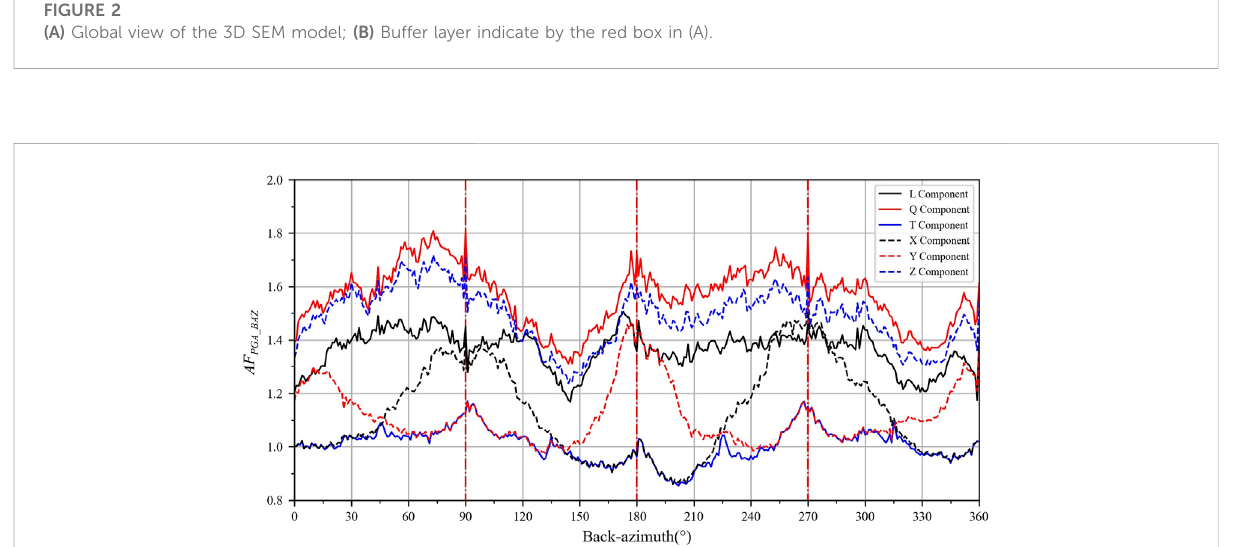
FIGURE 3 The relationship of AF PGA BAZ with back-azimuth, taking 1 ° as the interval. The solid black, red, and blue lines correspond to the L, Q, and T components, respectively; the dashed black, red, and blue lines correspond to the X, Y, and Z components, respectively. The red vertical dashdot lines are at 0 ° (360 ° ), 90 ° , 180 ° , and 270 ° for